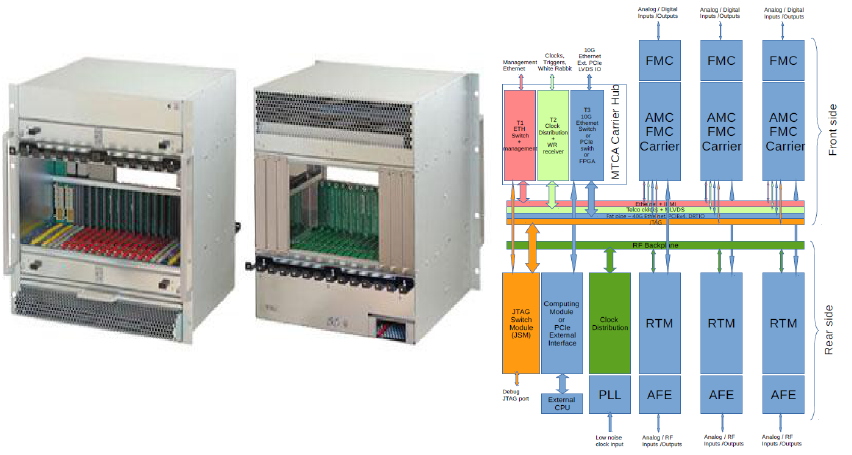
Figure 9. On the left: The Micro TCA.4 crate. On the right: An architecture of MicroTCA.4 standard